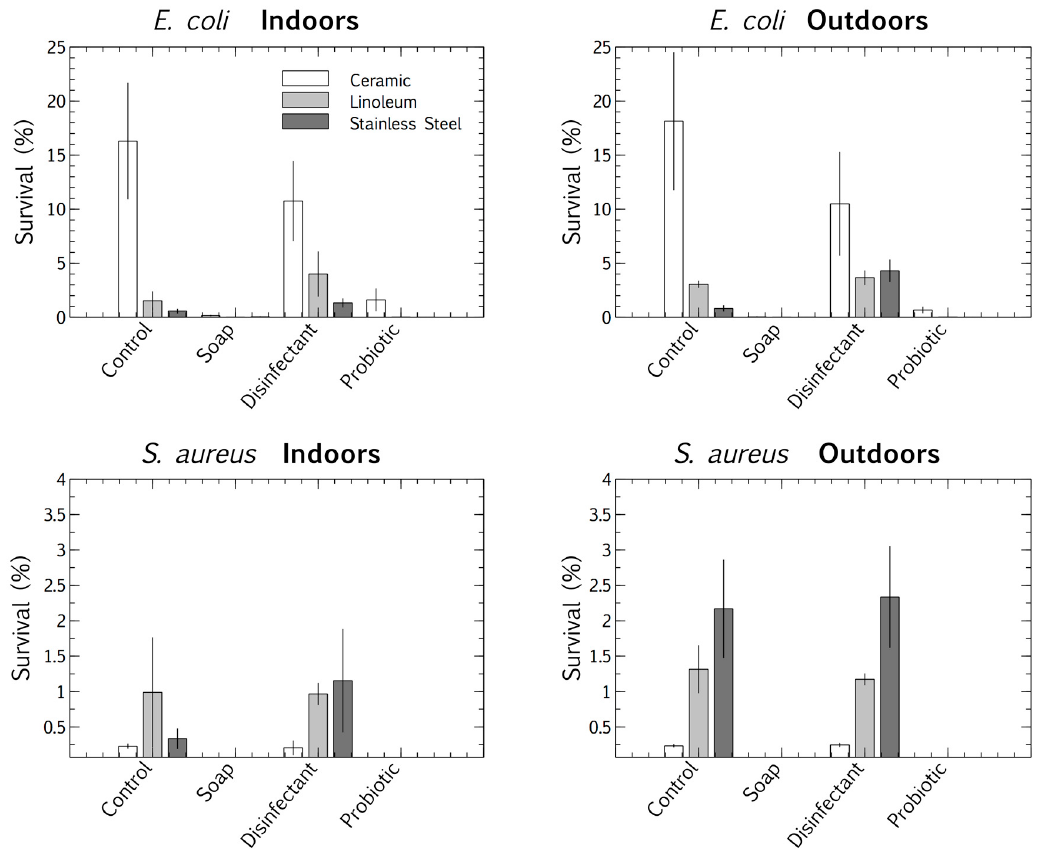
Figure 4. Percentage survival of E. coli and S. aureus after desiccation, deposited on three surfaces (ceramic, linoleum and stainless steel) indoors and outdoors, each treated with four cleaning regimes (tap water, plain soap, disinfectant, and probiotic cleaner). Results are expressed as mean ± SD of triplicate samples.